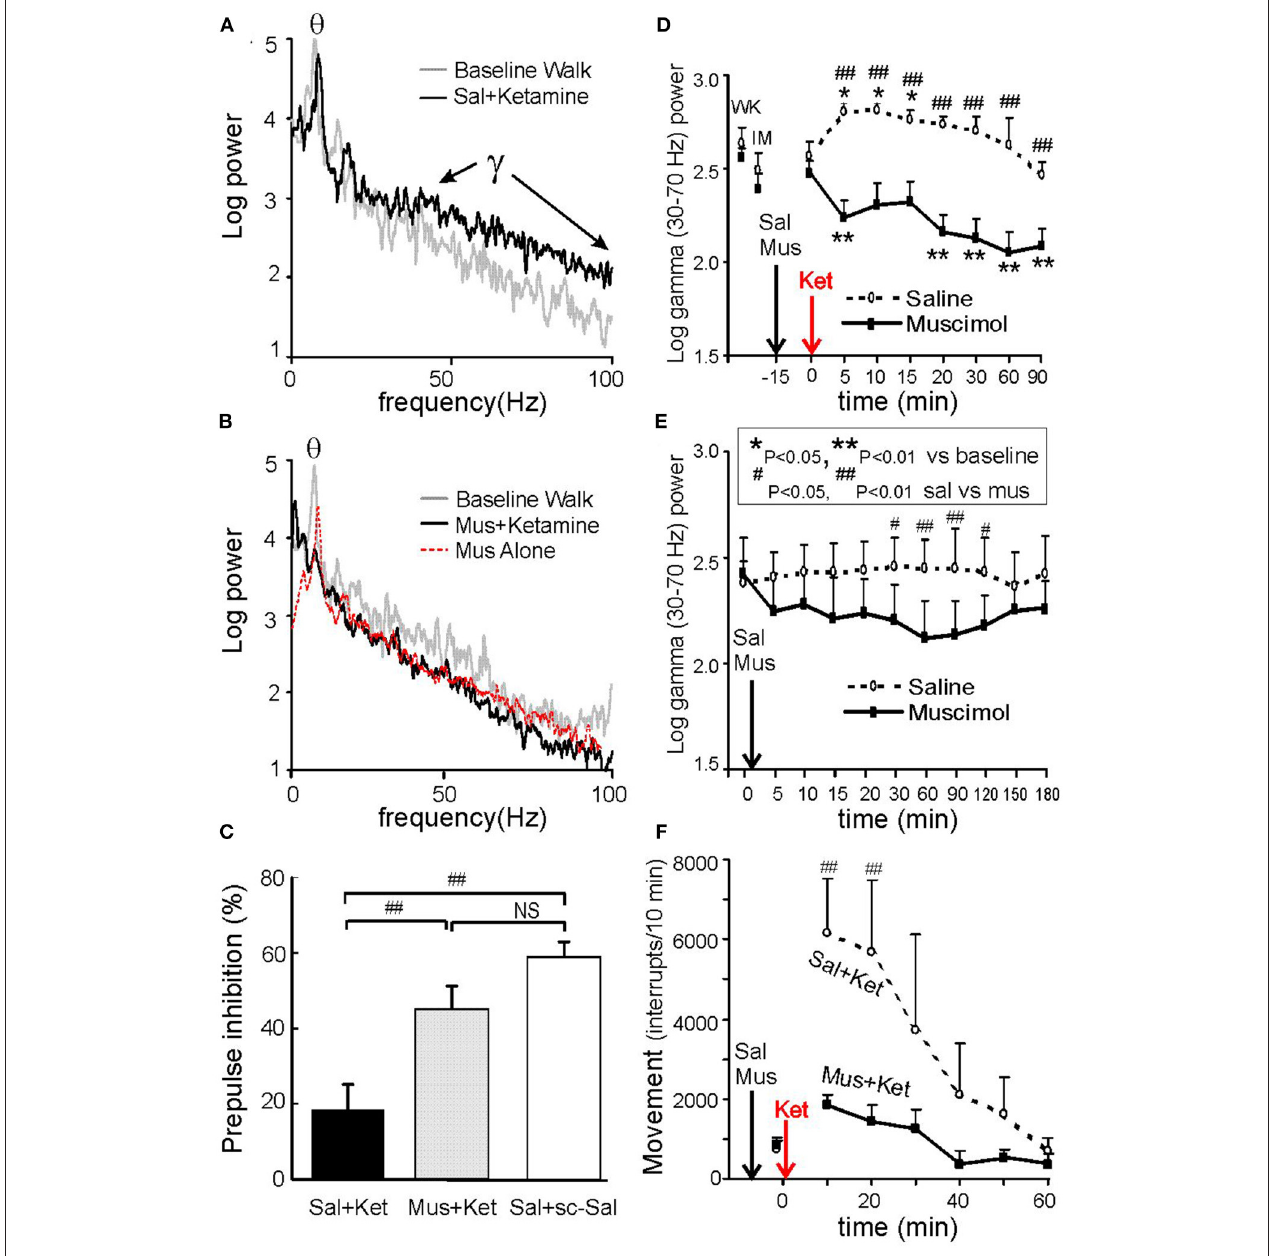
FIGURE 3 | Hippocampal gamma and behaviors induced by 0.6 mg/kg s.c. ketamine and control. (A) Power spectra of local field potentials recorded in CA1 stratum radiatum after intraseptal 0.6 µ l saline (Sal), compared with baseline walking; note increase of 30–100Hz gamma after ketamine. (B) Same as A except preceded by intraseptal infusion of 0.25 µ g/0.6 µ l muscimol (Mus) instead of Sal; both theta and gamma were decreased after ketamine; intraseptal Mus only reduced theta peak and 30–100Hz gamma as compared to baseline. (C) Prepulse inhibition (PPI) of the acoustic startle response (10–30min post-ketamine/ saline s.c.) shows low PPI after intraseptal Sal plus ketamine (Ket) as compared to Sal plus saline s.c.; low PPI induced by Ket was normalized by pretreatment with intraseptal Mus. (D) Time course of average 30–70Hz hippocampal gamma change with time after Ket injection, preceded by either intraseptal Sal or Mus infusion; gamma amplitude of ∼ 0.1mV = 2 log power units. (E) Average gamma (30–70Hz) change after intraseptal infusion of Sal or Mus only. (F) Horizontal movements measured by interrupts of infrared beams show lower movements after septal infusion of muscimol as compared to saline. After Ma and Leung (2007).